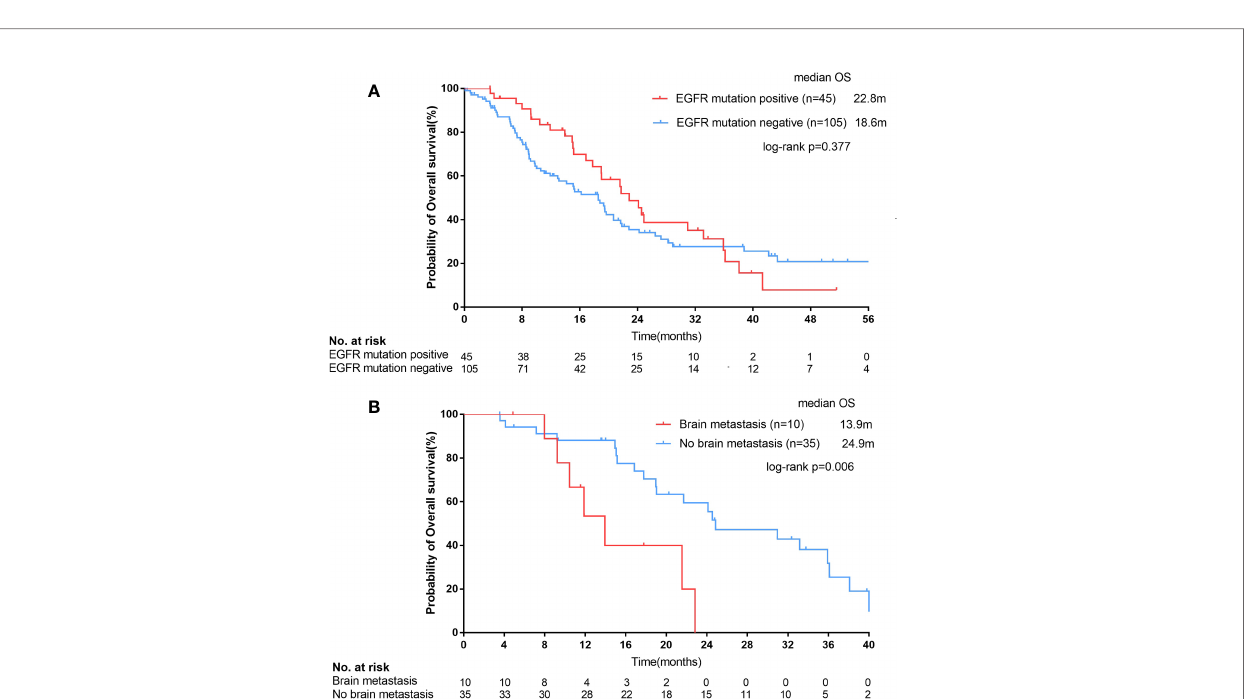
FIGURE 4 | For female squamous cell carcinoma (SCC) patients with epidermal growth factor receptor (EGFR) positive mutations, Kaplan – Meier curves of progression-free survival (PFS, A ) and overall survival (OS, B ) strati fi ed by receipt of EGFR tyrosine kinase inhibitor (TKI)